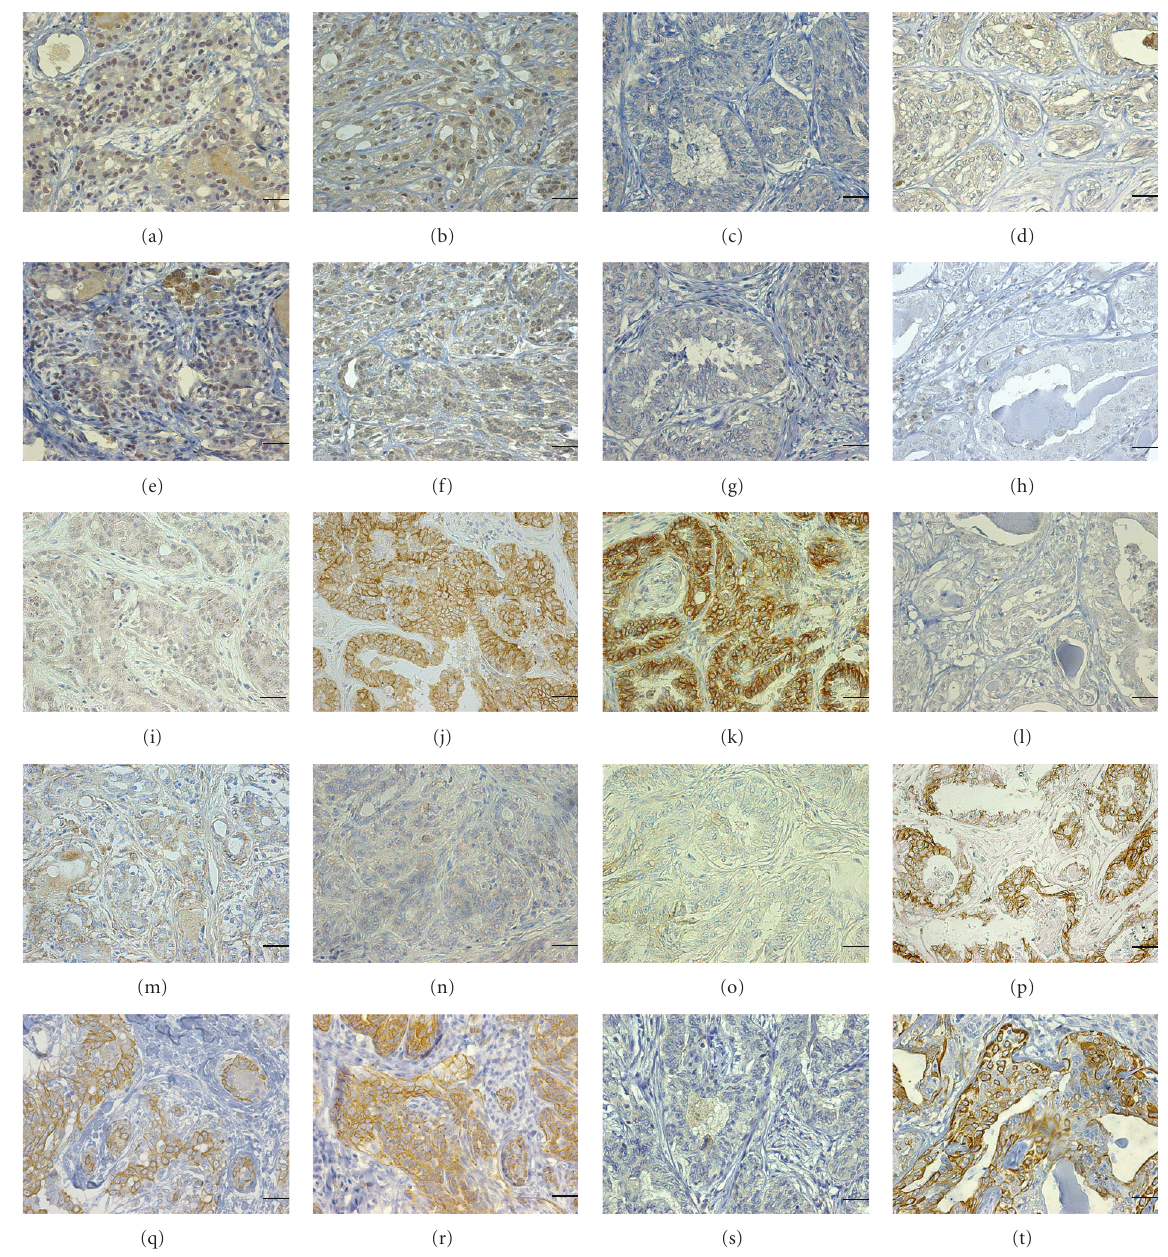
Figure 1: Immunophenotypic profiles of mammary carcinomas in benign-mixed tumors of female dogs’ mammary gland: Canis familiaris . (a)–(d) ER staining; (e)–(h) PR staining; (i)–(l) HER2 staining; (m)–(p) EGFR staining; (q)–(t) CK5 staining. Each column represents a distinct molecular subtype. From left to right: luminal A (case 13—RE: positive, RP: positive, HER2: negative, EGFR: negative, and CK5: positive). Luminal B (case 21—RE: positive, RP: positive, HER2: positive, EGFR: negative, and CK5: positive), HER2 (case 20—RE: negative, RP: negative, HER2: positive, EGFR: negative, and CK5: negative), and basal-like (case 17—RE: negative, RP: negative, HER2: negative, EGFR: positive, and CK5: positive). Advance HRP visualization method streptavidin-biotin complex method. Mayer’s hematoxylin counterstain Bar: 25 μ